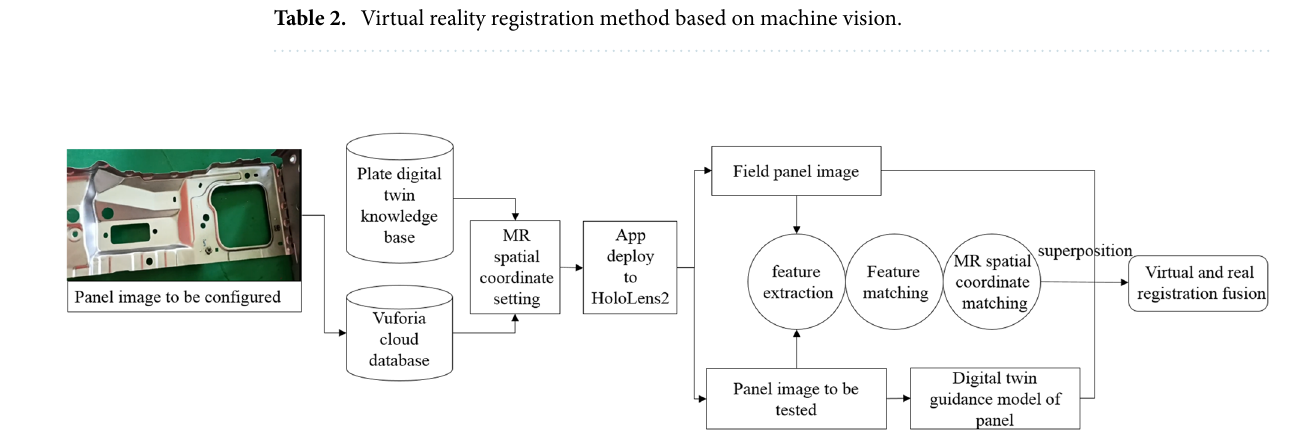
Figure 4. Virtual real registration fusion process based on